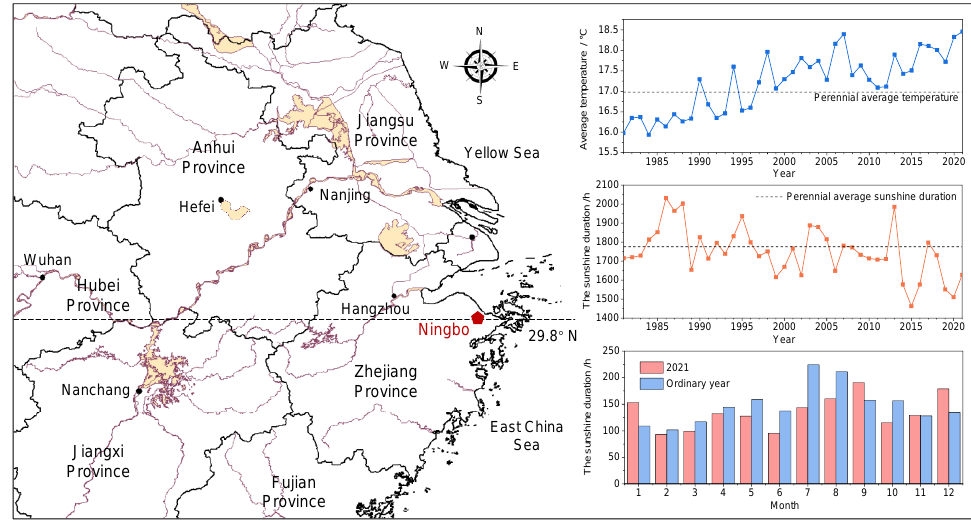
Figure 1. Sampling and test sites climatic conditions.